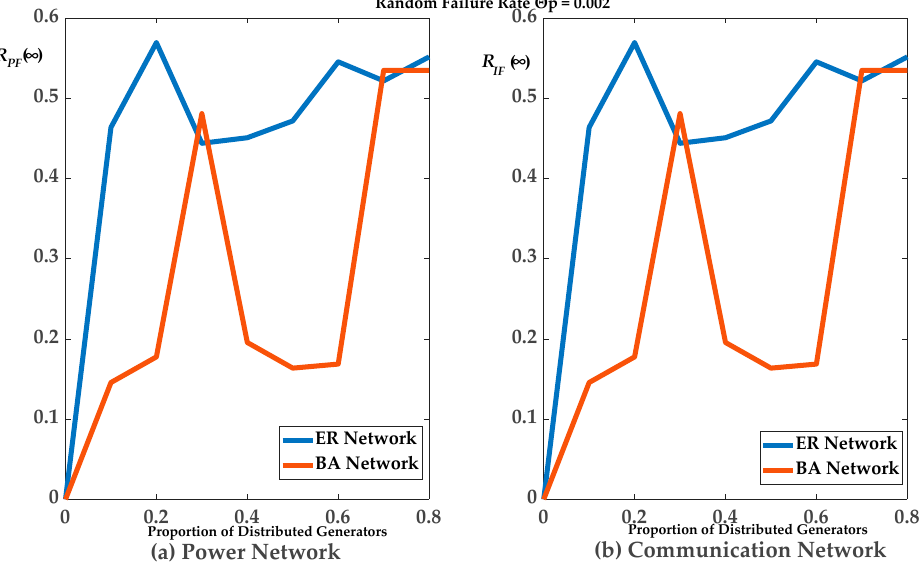
Figure 10. R PF ( ∞ )/ R IF ( ∞ ) of different network topology under different proportion of distributed generators and the unintentional-random-initial-failure-rate Θ P = 0.002.